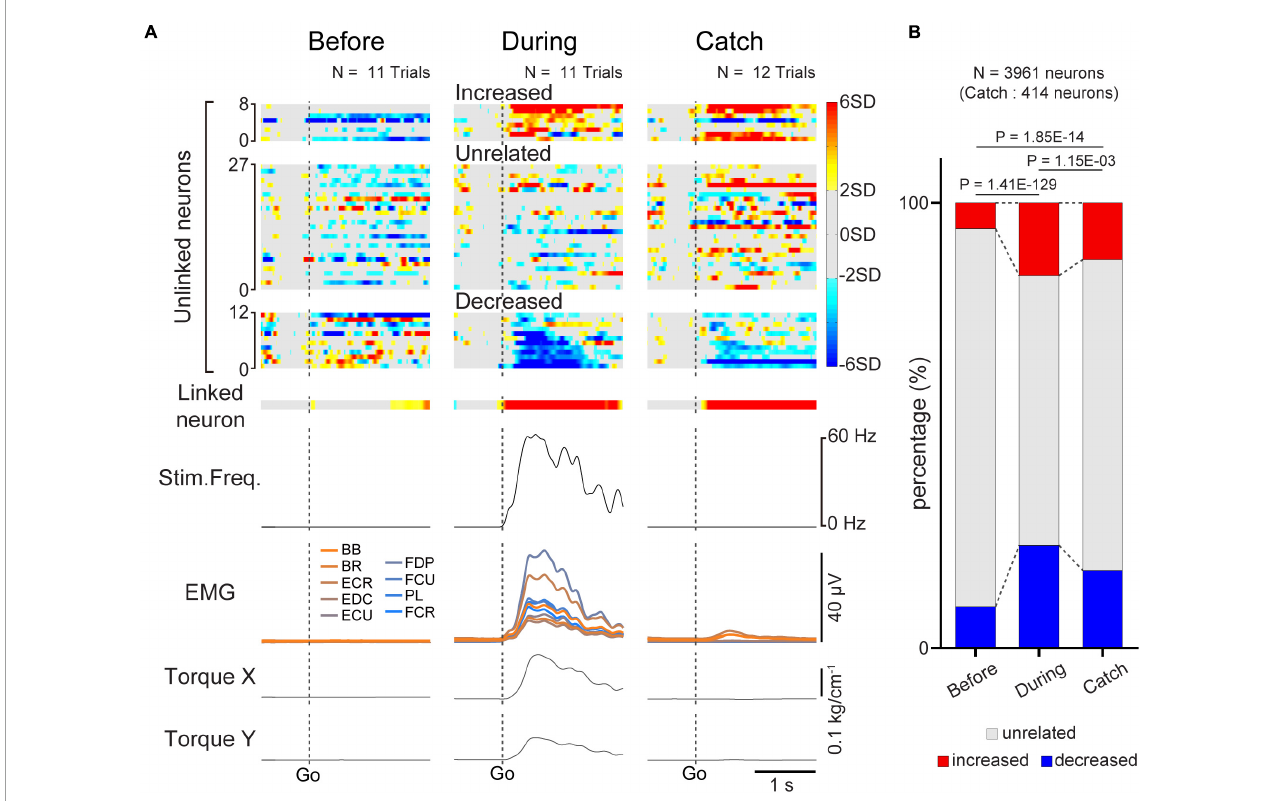
FIGURE5 Task-related modulation of unlinked neurons. (A) Examples of average firing rate of M1 cells (1st and 2nd rows), stimulus frequency (3rd row), EMG of the forelimb (4th row), and wrist torque (5th and 6th rows) before (left panel) and during the corticospinal interface trials (center panel) and during the catch trials (right panel). Z -scored firing rates of unlinked (1st row) neurons and linked (2nd row) neurons are shown. Unlinked neurons are sorted into “increased”, “decreased”, and “unrelated” neurons according to activity during the corticospinal interface sessions. Plots are aligned to the timing of target appearance (“Go”), indicated by the vertical dotted lines. (B) The percentage of the types of unlinked neurons (red: “increased” neuron, black: “unrelated” neuron, blue: “decreased” neuron) before and during the corticospinal interface and catch trials. Black horizontal lines represent significant differences ( P < 1.67 × 10 − 2 by Chi-squared test with Bonferroni’s correction for post hoc multiple